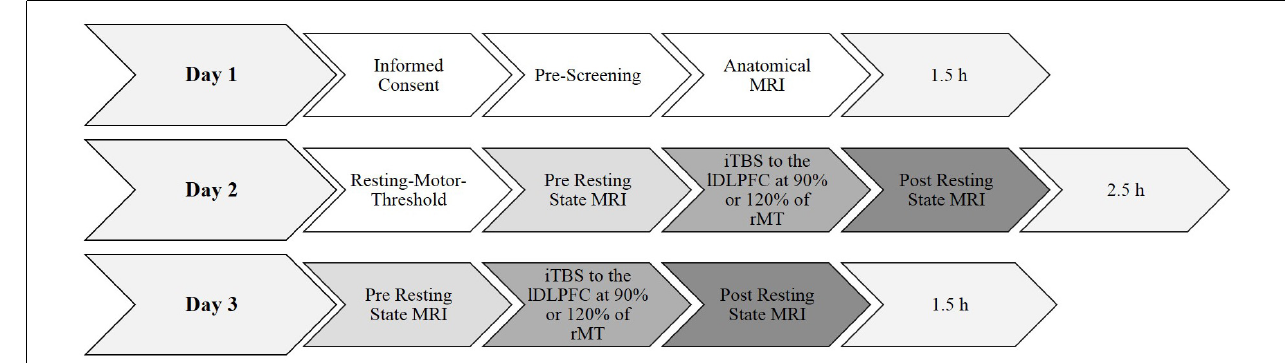
FIGURE 1 | Summary of the experimental design and durations. Day 1 and day 2 took 1.5 h each. Determining the resting-motor threshold took approximately 45 min. All anatomical and functional magnetic resonance imaging (fMRI) scans took approximately 10 min each. The experimental procedure took in total approximately 5.5 h per participant. rMT, resting motor